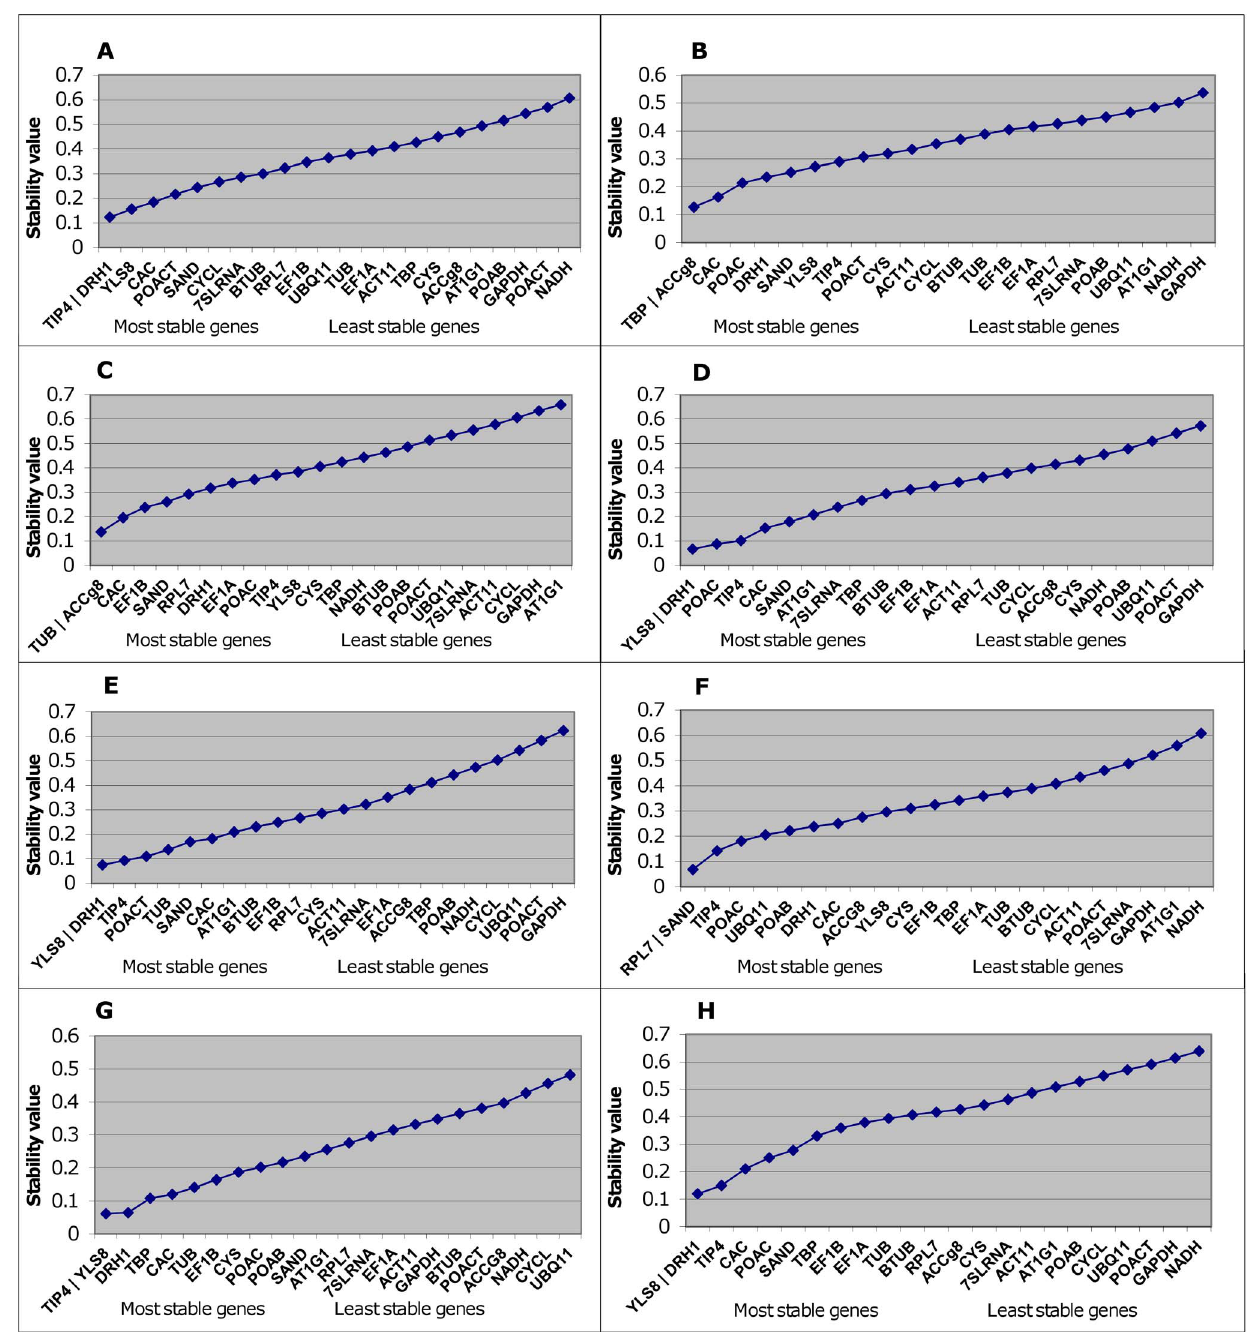
Figure 3. Average expression stability values (M) calculated by geNorm. The genes are ranked according to their expression stability; the least stable genes are on the left, and the two most stable genes are on the right. The samples are divided into sub-groups: (A) susceptible plants of cv. Celeia; (B) resistant plants of cv. Wye Target; (C) plants infected with Verticillium albo-atrum ; (D) control (non-infected) plants; (E) plants evaluated 10 days post inoculation with fungi; (F) plants evaluated 20 days post inoculation with fungi (G) plants evaluated 30 days post inoculation with fungi (H) all plant samples. the optimum pair of genes ( POAC/DRH1 ) does not include the experiments. Based on the two different grouping conditions, the optimum single gene ( ACCg8 ), which is the consequence of the single genes CAC and ACCg8 were revealed to be optimal, or SAND / CAC and POAC / DRH1 in the case of a combination of the compensating expression of the resulting most stable pair, so that one gene is slightly over-expressed in one group but the other gene two best reference genes. The differences obtained as the is correspondingly under-expressed in the same group and it consequence of the grouping influence are well shown in therefore differs from the resulting best single gene [24]. The Figure 5. In the second grouping (infected vs. non-infected plants),